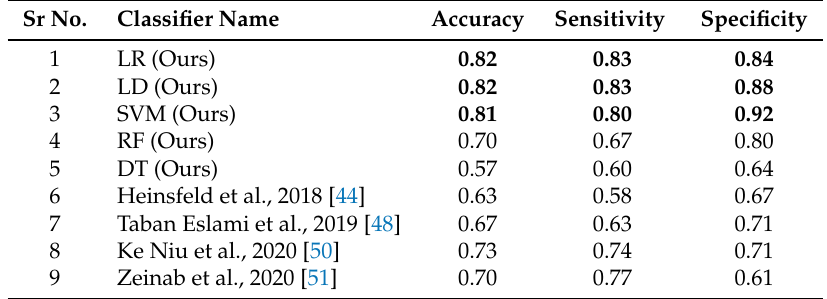
Table 11. 10-Fold Results Comparison of our 3-Stage approach-based selected Features on an all-Site combined